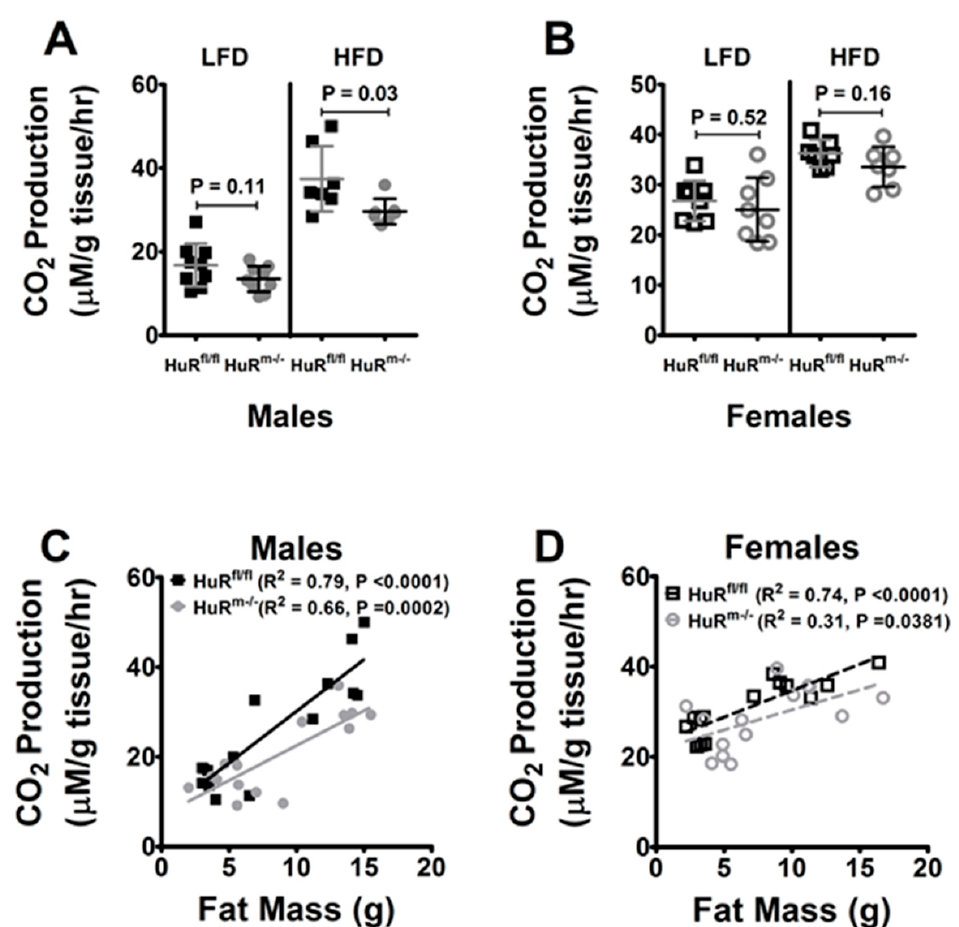
Figure 5. Increased dietary fat activates lipid oxidation less robustly in HuR m − / − mice. ( A ) Palmitate oxidation as measured by CO 2 production in gastrocnemius homogenates from control (black) and HuR m − / − (grey) male mice fed either LFD or HFD ( n = 7–9). ( B ) Palmitate oxidation in gastrocnemius homogenates from control (black) and HuR m − / − (grey) female mice ( n = 8–9) fed either LFD or HFD. ( C ) Palmitate oxidation in gastrocnemius as a function of fat mass for control (black) and HuR m − / − (grey) male mice. ( D ) Palmitate oxidation in gastrocnemius as a function of fat mass for control (black) and HuR m − / − (grey) female mice.